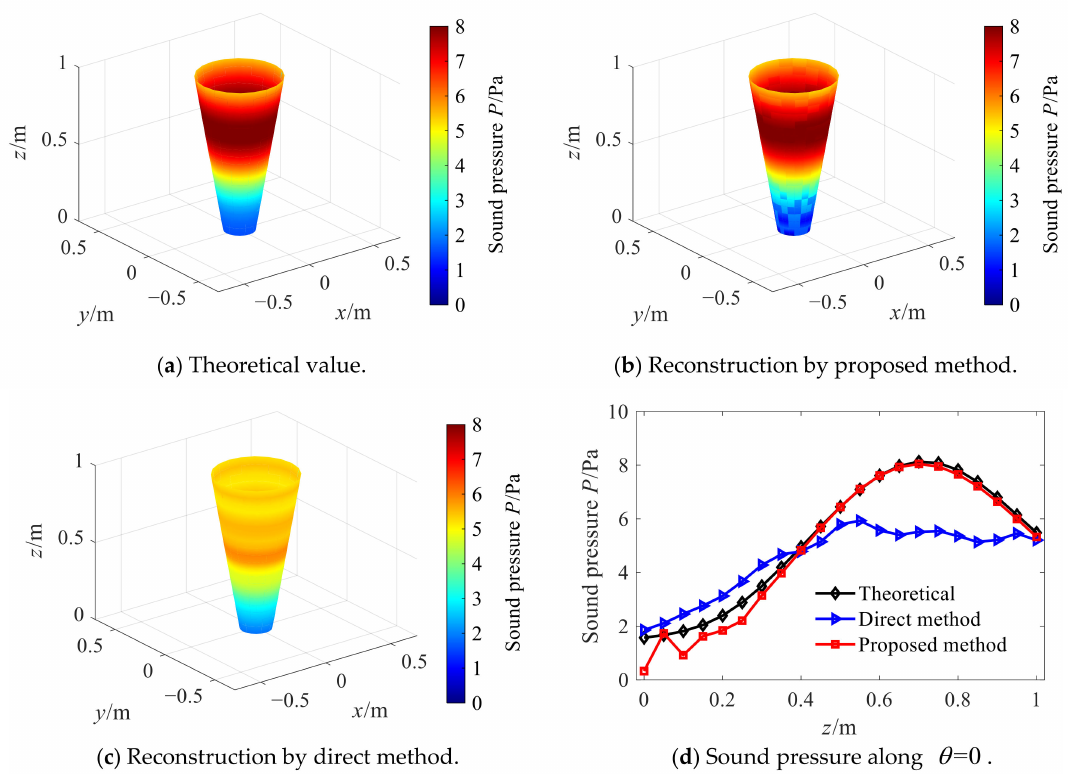
Figure 9. Reconstruction with cone angle 20 ◦